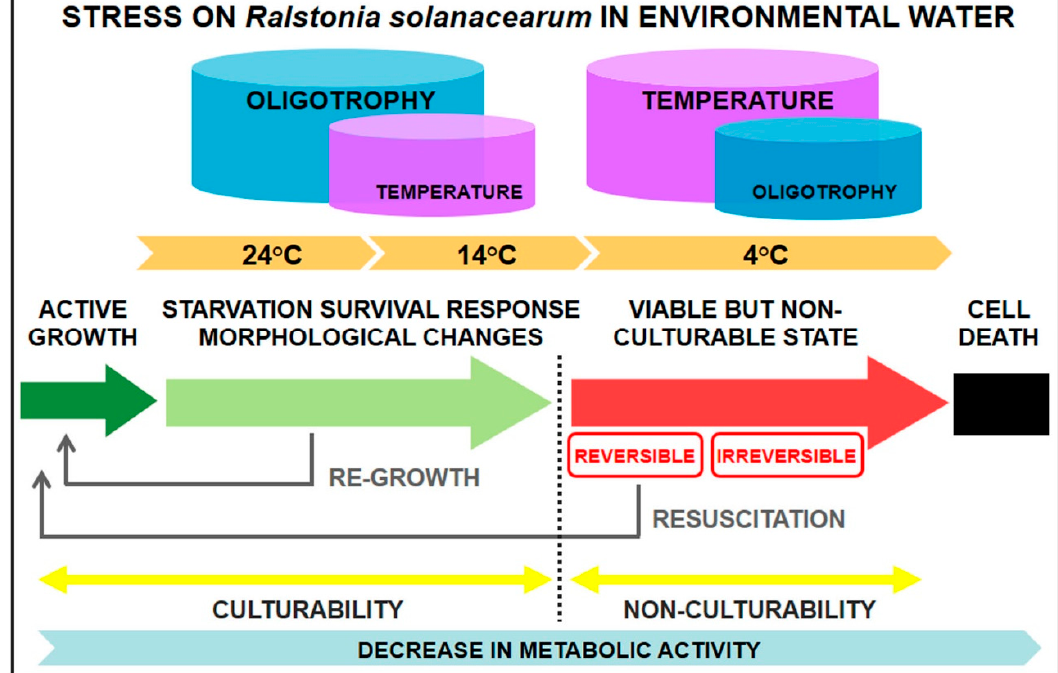
Figure 6. Influence of temperature and oligotrophy on Ralstonia solanacearum stress induction in environmental water and stress responses by the bacterium. Adapted to R. solanacearum from a proposed model by [67]. See text for details.